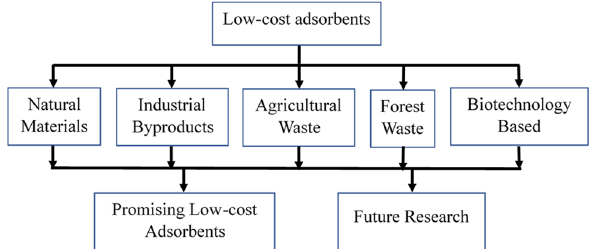
Fig. 1 A schematic of the study